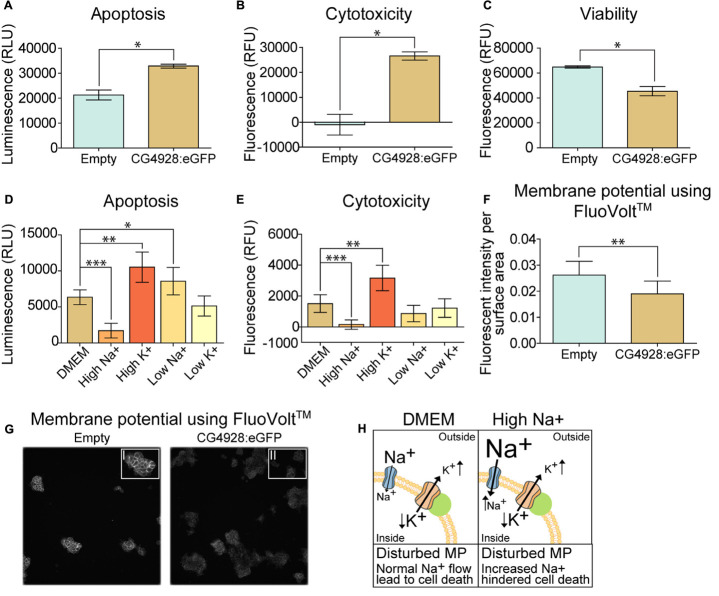
Overexpression of CG4928 induces apoptosis and alters the membrane potential. The CG4928:eGFP-transfected cells had a decline in cell number at 24 h post-transfection, and therefore apoptosis, cytotoxicity, and viability were monitored using the ApoTox-GloTM Triplex kit. Fluorescence and luminescence were measured, mean fluorescence and luminescence signals (±SEM) (n = 2 with 12 measured points in each) were plotted, and differences were studied using unpaired t-test (*p < 0.05, **p < 0.01, ***p < 0.001). CG4928:eGFP-transfected cells had (A) higher apoptosis, (B) cytotoxicity, and (C) lower viability. The CG4928:eGFP-transfected cells were maintained in different media [normal Dulbecco’s modified Eagle’s medium (DMEM), high sodium, high potassium, low sodium, and low potassium media] to investigate changes in cell death. The mean fluorescent and luminescence signals (±standard error of the difference) (n = 6) were plotted and CG4928:eGFP-transfected cells on normal DMEM media was used as control. Differences were calculated using appropriate ANOVA [one-way ANOVA (apoptosis) or Kruskal–Wallis (cytotoxicity)] with unpaired t-test or Mann–Whitney as post hoc test (adjusted p-values: *p < 0.0489, **p < 0.0099, ***p < 0.0001). (D) Changes in apoptosis were observed in transfected cells maintained on high sodium, high potassium, and low sodium, (E) while only high sodium and high potassium altered the cytotoxicity. The speculated interaction between CG4928 and TASK1 channels suggests that the results could be linked to the membrane potential. Therefore, the membrane potential was measured using the FluoVoltTM membrane potential kit. The average fluorescent intensity per area was calculated from each frame at each timepoint per well (n = 4, images taken for two sites with an interval of 10 s for each of the 10 timepoints). Graphs with 95% confidence interval were generated and unpaired t-tests were performed (*p < 0.05, **p < 0.01, ***p < 0.001). (F) The basal membrane potential was lower in CG4928:eGFP-transfected cells compared with the control. (G) Representative image of the difference in fluorescent intensity between CG4928:eGFP-transfected cells and the controls. (H) Taken together, it can be speculated that CG4928 is important for TASK1 channel function and/or regulation. Overexpression of CG4928 probably caused potassium leakage, leading to disturbed membrane potential and cell death. Cell death could be hindered by culturing the CG4928-overexpressing cells in high sodium concentrations, but the mechanisms behind the rescue still remain uncertain.